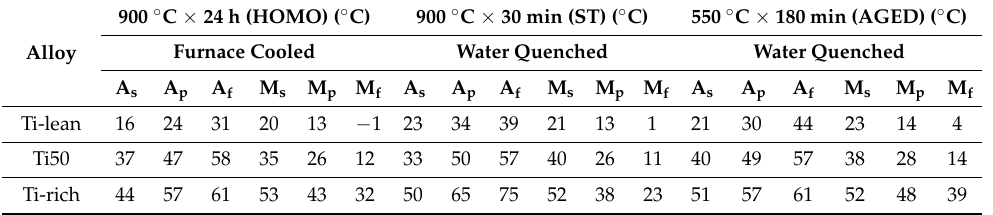
Table 2. Transformation temperatures as measured by DSC of homogenized, solution-treated and aged alloys A. The thermal rate was set to 10 ◦